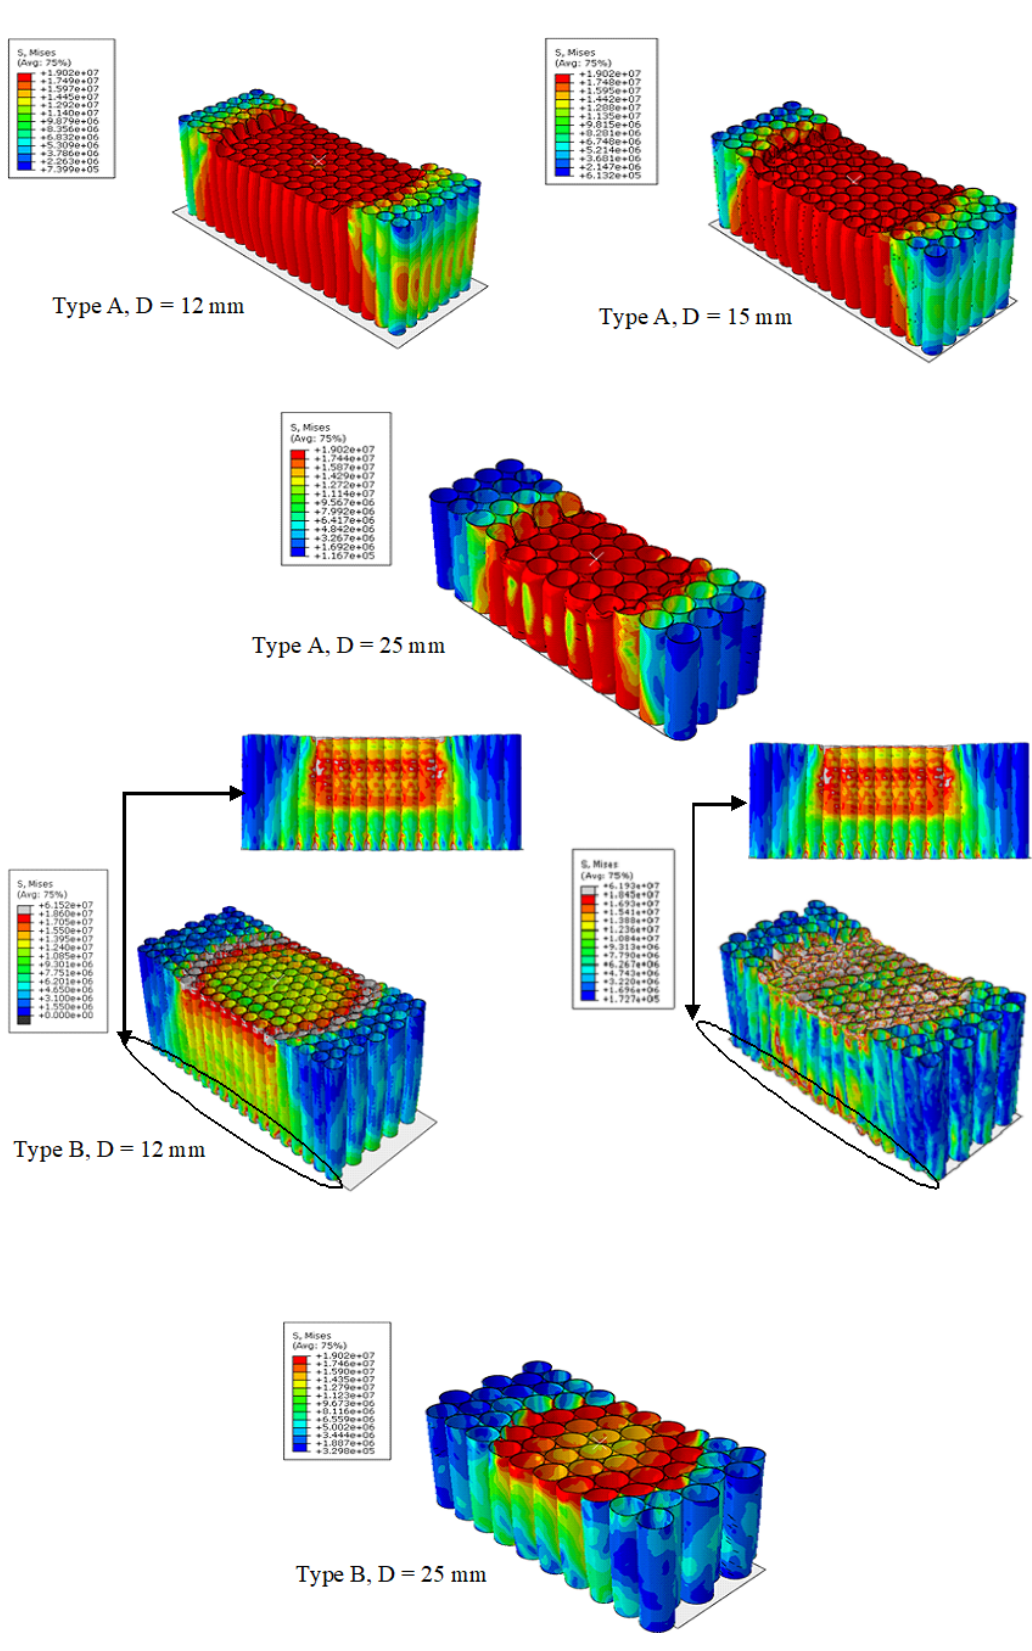
Figure 8: Characteristics of crashworthiness of circular aluminum honeycomb Type A and Type B at 4 m height by FEA model